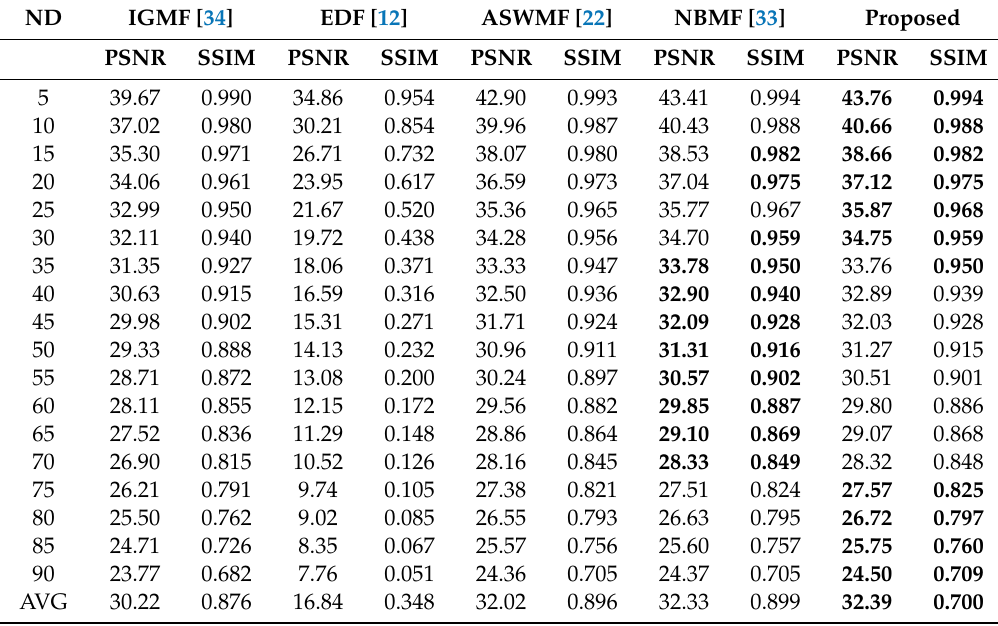
Table 4. The results of the noise cancelation